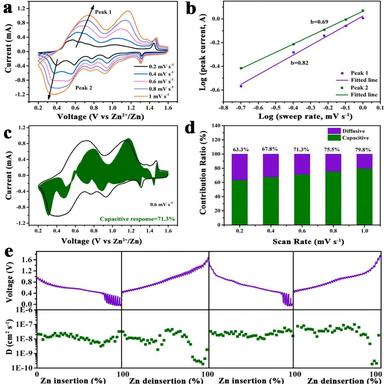
(a) CV curves at different scan rates of CoVO-150, (b) relationship between the peak current and the scan rate, (c) contribution ratio at a scan rate of 0.6 mV s − 1 , (d) contribution ratios in the CoVO-150 at various scan rates, (e) GITT curves and corresponding Zn2+ diffusion coefficient at discharge/charge state of CoVO-150.